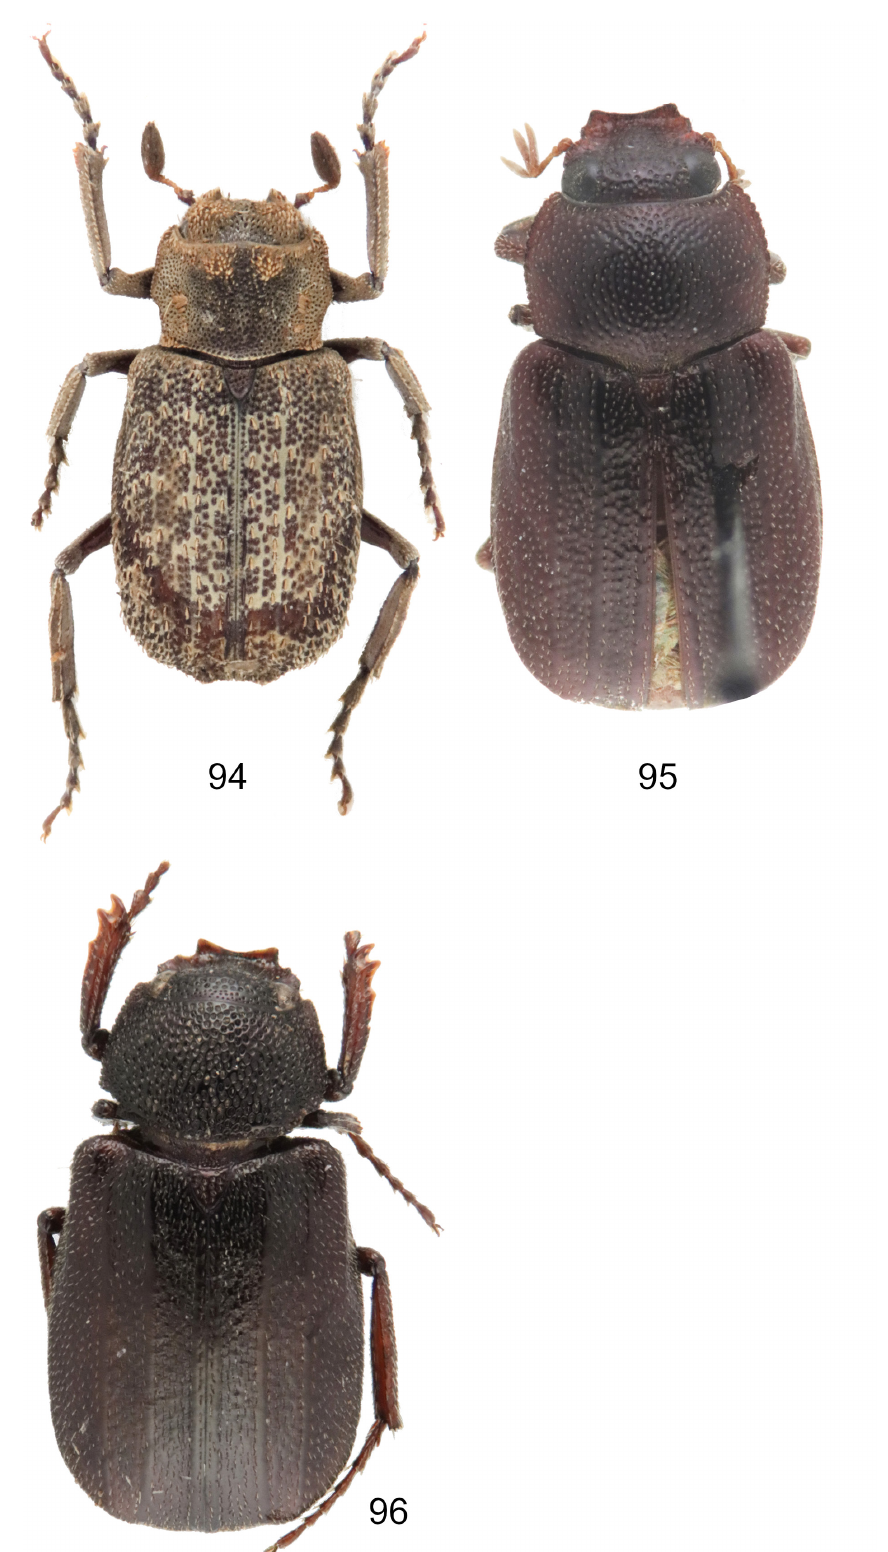
Figs 94–96. Papuan and Wallacean Maechidius Macleay, 1819, habitus, dorsal view. 94 . M. weigeli sp. nov., holotype, ♂ (NME). 95 . M. woodlarkianus Heller, 1914, lectotype, ♀ (SNSD). 96 . M. yamdena sp. nov., paratype, ♂ (BMNH). Not to